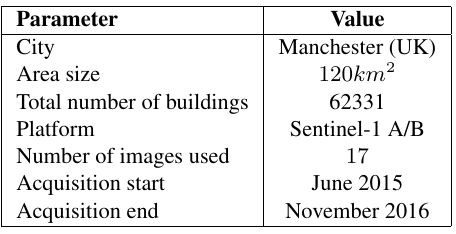
Table 1: Description of the case study